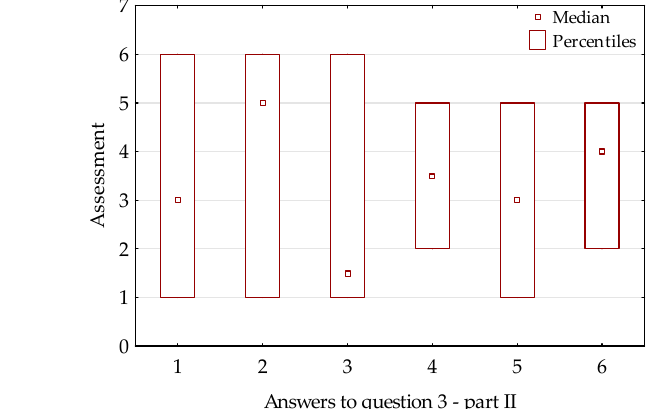
Table 5. Characteristics of the material prepared by Erasmus+ students, introducing the reader to the subject of the ideal dairy farm, including citations.